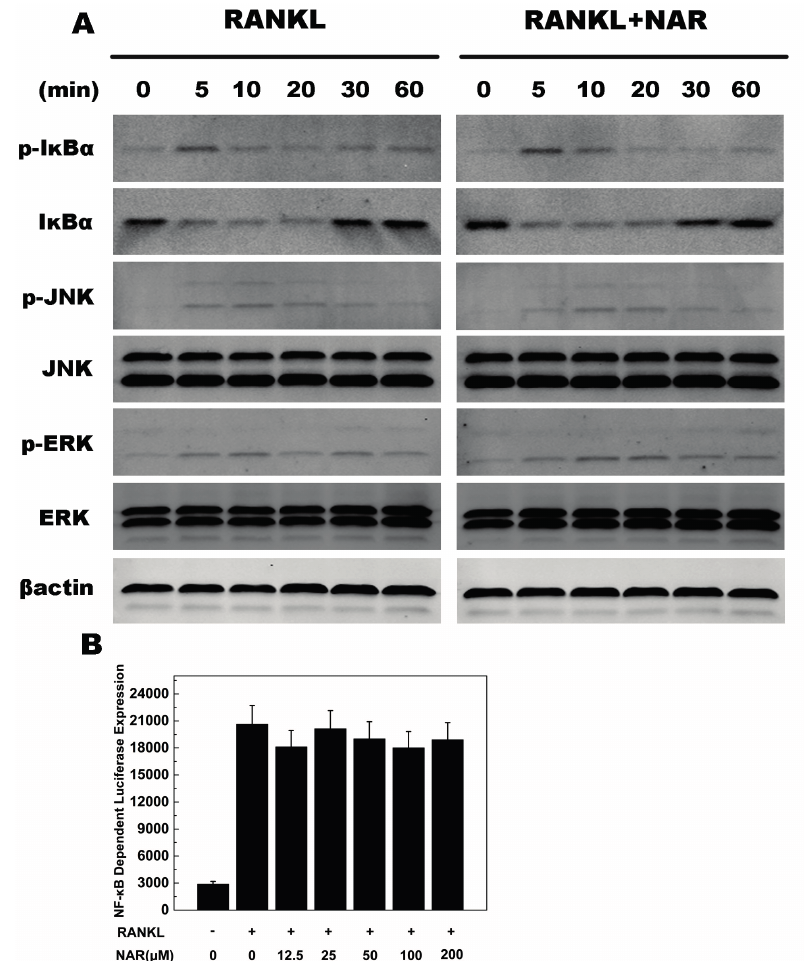
Figure 7. Naringenin (NAR)-mediated effects on receptor activator of the nuclear factor- κ B ligand RANKL-induced nuclear factor κ B (NF- κ B), c-Jun N -terminal kinase (JNK), and extracellular signal-regulated kinase (ERK), signaling ( A ) The levels of p-I κ B α , I κ B α , p-JNK and p-ERK were unaffected by exposure to 200 μ M NAR; ( B ) Luciferase reporter assays showed that NAR did not affect RANKL-induced NF- κ B